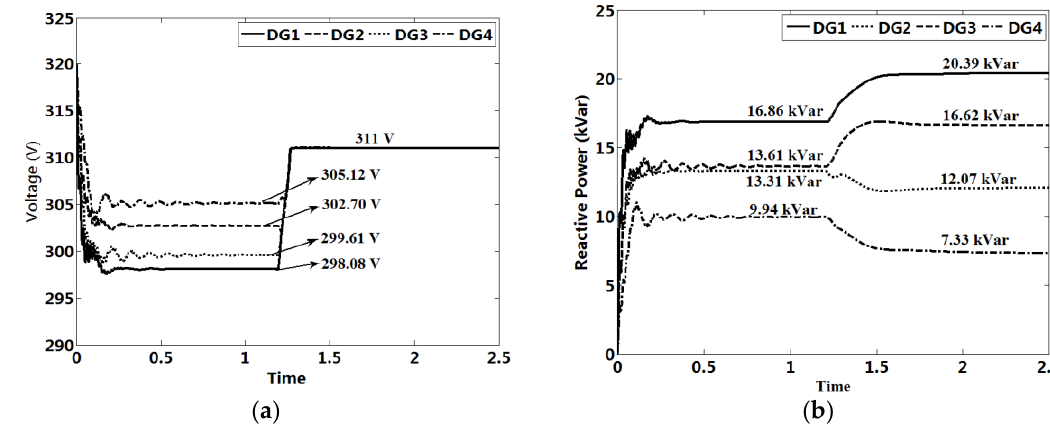
Figure 8. Simulation results of the secondary voltage control. ( a ) the amplitude voltage and ( b ) the reactive power of DGs.